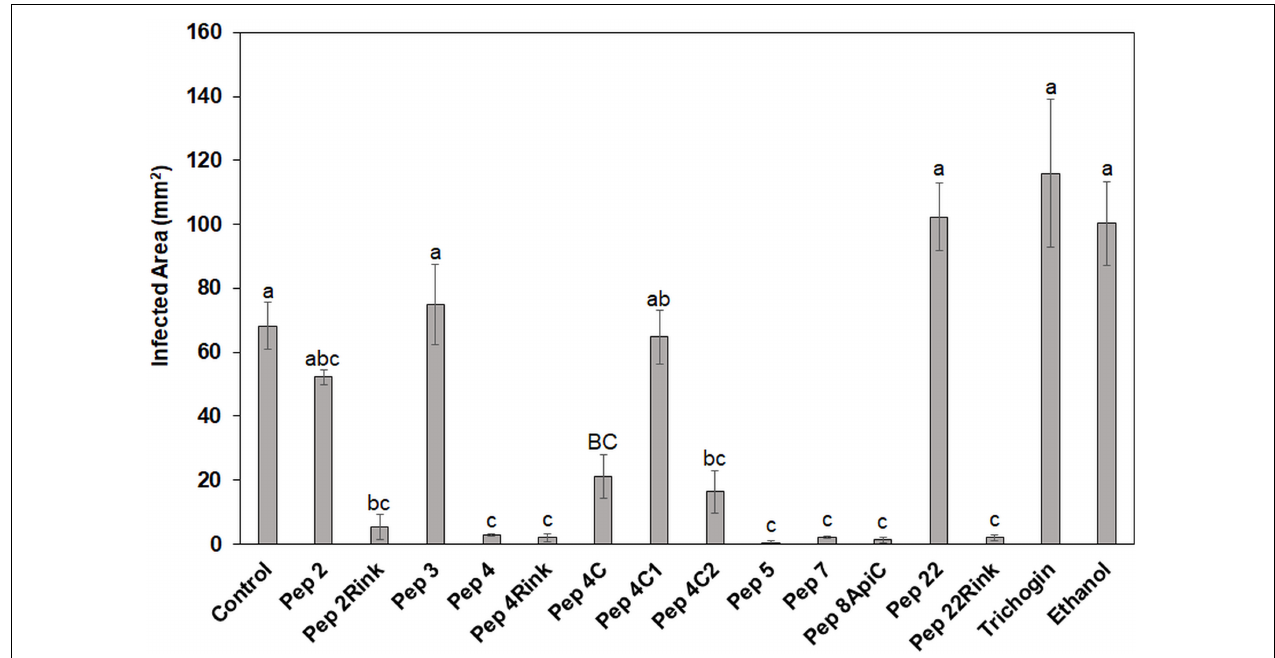
FIGURE 2 | Data represent the lesion area (expressed in mm 2 ) caused by Pyricularia oryzae IT10 strain on barley leaves (cv. Alora) at 7 days post-inoculation (dpi) and are the mean of at least three independent biological replicates. Standard errors were indicated by error bars. Significant inhibition ( p < 0.05) of lesions was observed with Pep 2Rink, 4, 4Rink, 4C, 4C2, 5, 7, 8Api and 22Rink compared to the Control. Trichogin at 50 µ M concentration, resuspended in 3% (v/v) ethanol, and 3% (v/v) ethanol were also included as negative controls. Data were statistically analyzed by applying the one-way Anova Bonferroni–Holm test (different lowercase letters indicate significant differences at p < 0.01, different uppercase letters indicate significant differences at p <